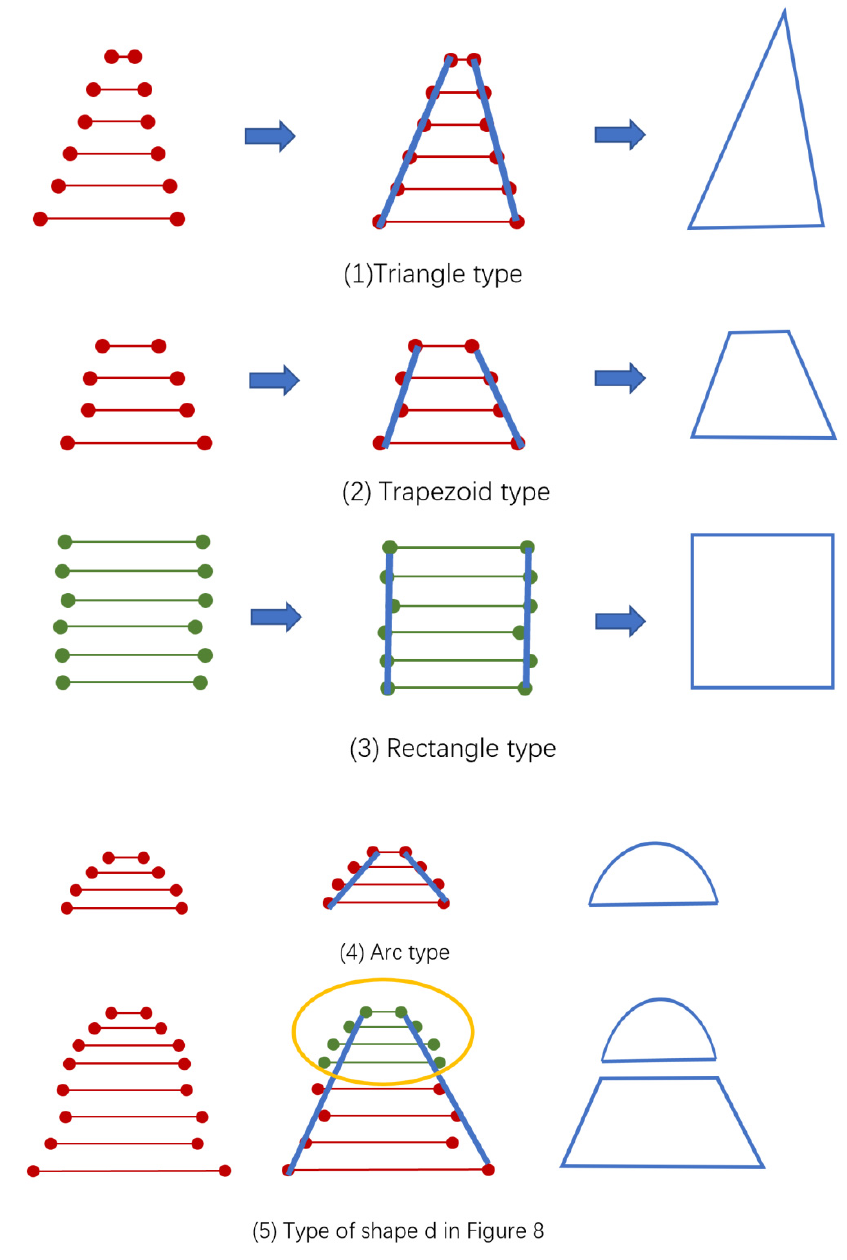
Figure 15. The shape fitting of different tree crowns. ( 1 )~( 4 ) shows the fitting process of the basic shape of the crown. Most of the combined shapes are composed of the basic shapes. ( 5 ) The fitting process of shape D in Figure 10 is particularly evident.